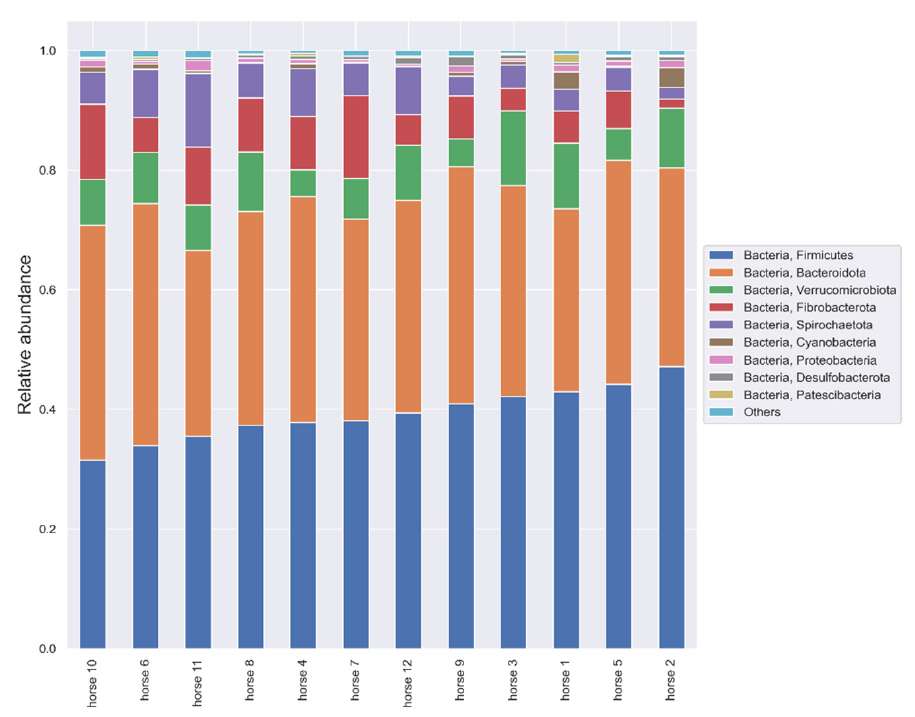
Figure 2. Relative abundance of microbiota from horse feces at the phylum level. Taxonomy based on V3–V4 hypervariable region of 16S rRNA gene. Phyla whose relative abundance accounts for less than 0.01 are found in Others.